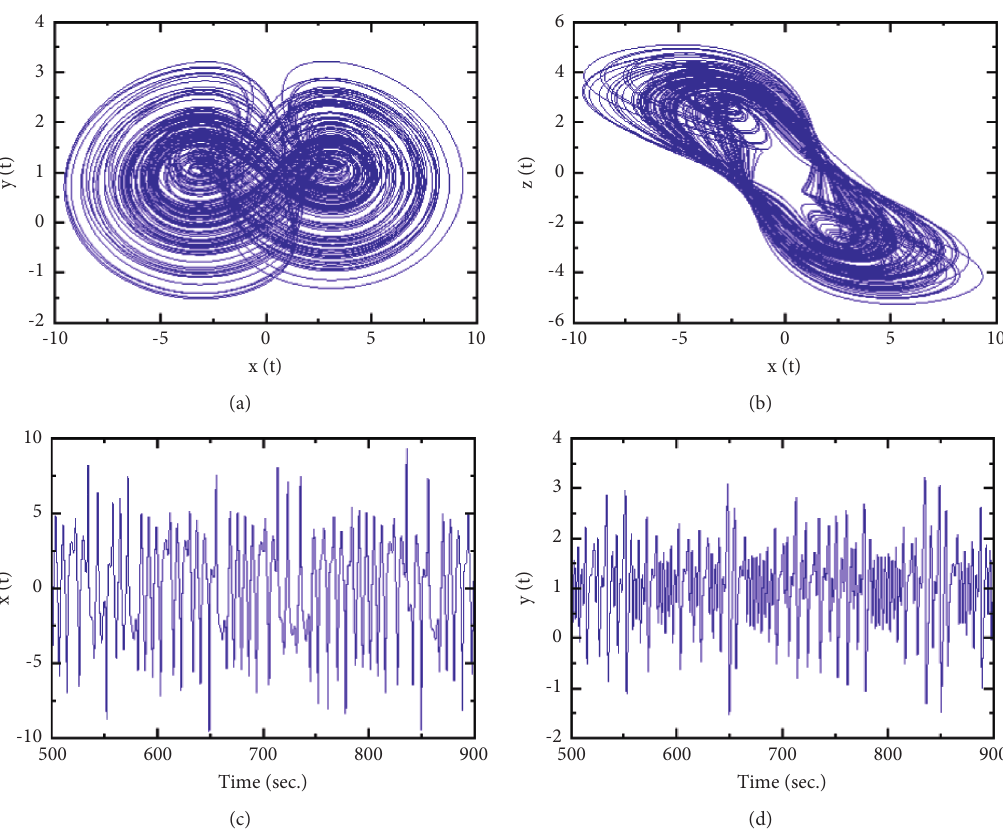
Figure 1: Phase diagrams and time series of system (5): (a) projected onto the x − y phase plane, (b) projected onto the x − z phase plane, (c) time series of x , and (d) time series of y